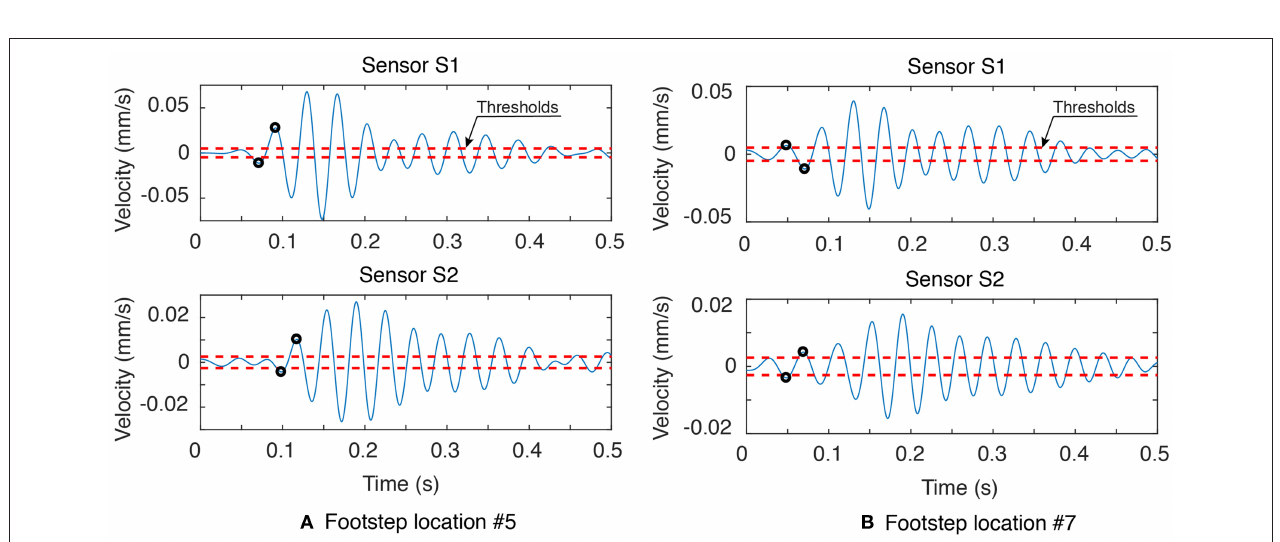
FIGURE 14 | Low frequency components of two footstep signals are extracted using wavelet decomposition between 23 and 30Hz. Footstep signals recorded at Sensors S1 and S2 are located at (A) Footstep location #5 and (B) Footstep location #7 (see Figure 4 ). Thresholds (Dashed-lines) correspond to three standard deviations of ambient vibrations for each sensor. Black dots illustrate the first peak exceeding thresholds for each sensor.